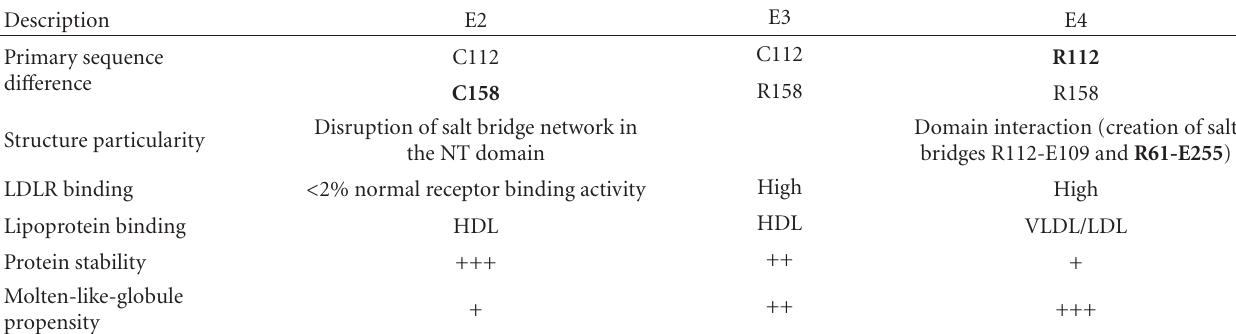
Figure 1: Illustration of the lipid-free (a) and DPPC-bound (b) conformational states of APOE isoforms. (a) In a lipid-free state, the NT and CT domains of APOE interact with each other. (b) The tridimensional conformation of APOE significantly changes when bound to lipid and adopts the shape of a horseshoe, with the CT domain oriented toward the lipoprotein surface. APOE or E: apolipoprotein E; the red dots line represents salt bridges; C: cysteine; R: arginine; E: glutamate; DPPC: dipalmitoylphosphatidylcholine; NT: N-terminal domain containing the low-density lipoprotein binding sites; CT: C-terminal domain comprising the lipoprotein binding and APOE self-association sites. Table 1: Key structural and functional di ff erences between the three main human APOE isoforms.